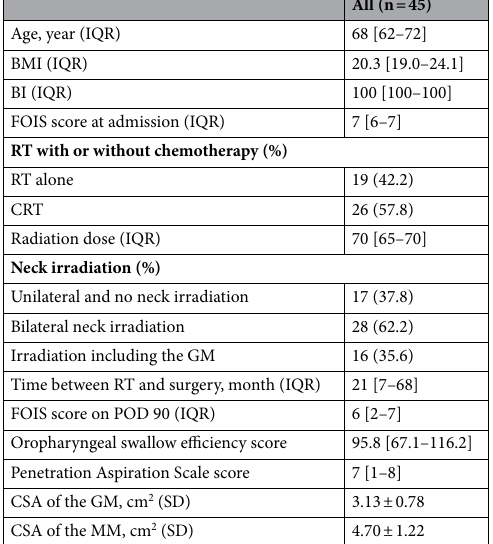
Table 1. Patients’ characteristics. IQR interquartile range, BMI body mass index, BI Barthel Index, FOIS Functional Oral Intake Scale, RT radiotherapy, CRT chemoradiotherapy, CSA cross-sectional area, GM geniohyoid muscle, MM masseter muscle, SD standard